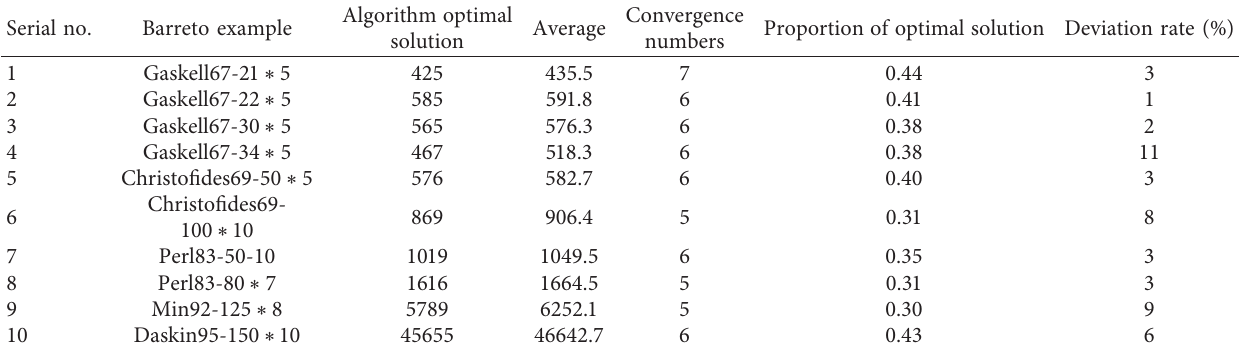
Table 3: Efficiency and